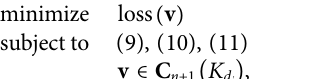
Figure 5 . For the persistence interval [ b i , d i ) , the cycle with